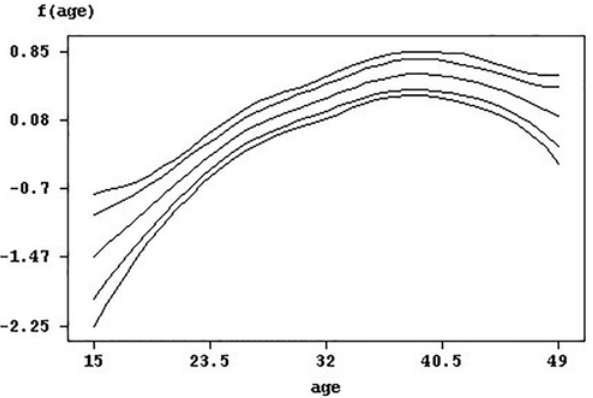
Fig 4. Effect of woman's age with pointwise 95% and 80% credible